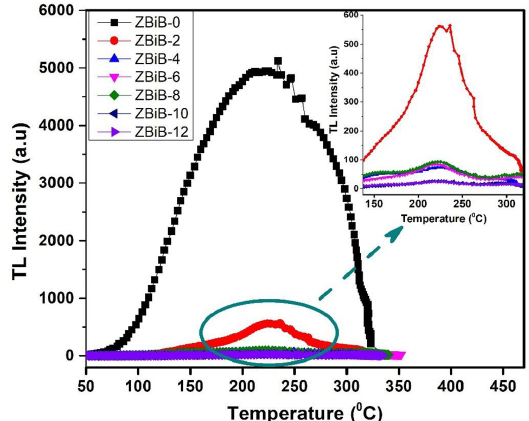
Figure 9. Glow curves of 5 kGy gamma- irradiated glass samples in the temperature range of